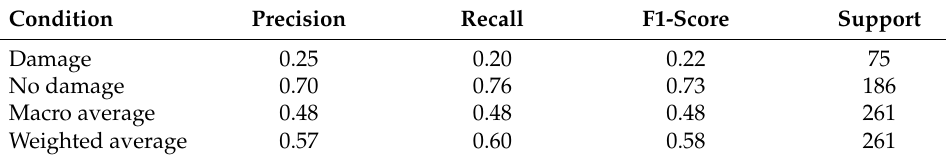
Table 16. Classification report from testing on 261